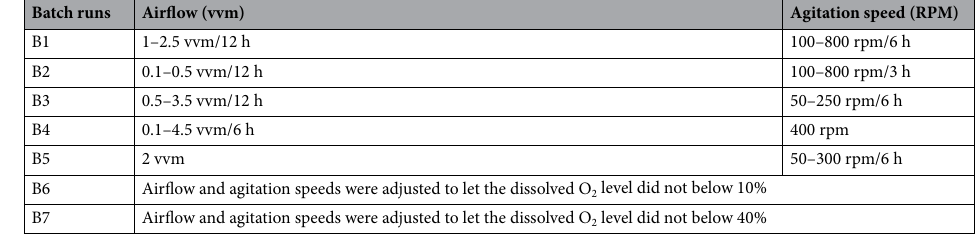
Table 10. Optimization of the fungal biomass and MnO NPs production by studying different aeration/ agitation rates and its timing, all the way via controlled batch fermentation modeusing7L bioreactor.